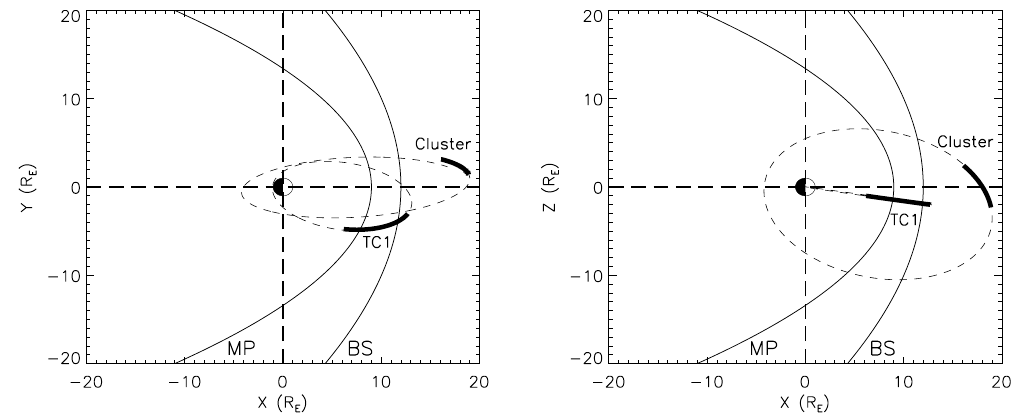
Fig. 1. Trajectories of TC-1 and Cluster projected to the GSE X-Y and X-Z planes for the interval 04:00–12:00UT on 26 February 2004. Also shown are the nominal locations of the magnetopause (MP) and the bow shock